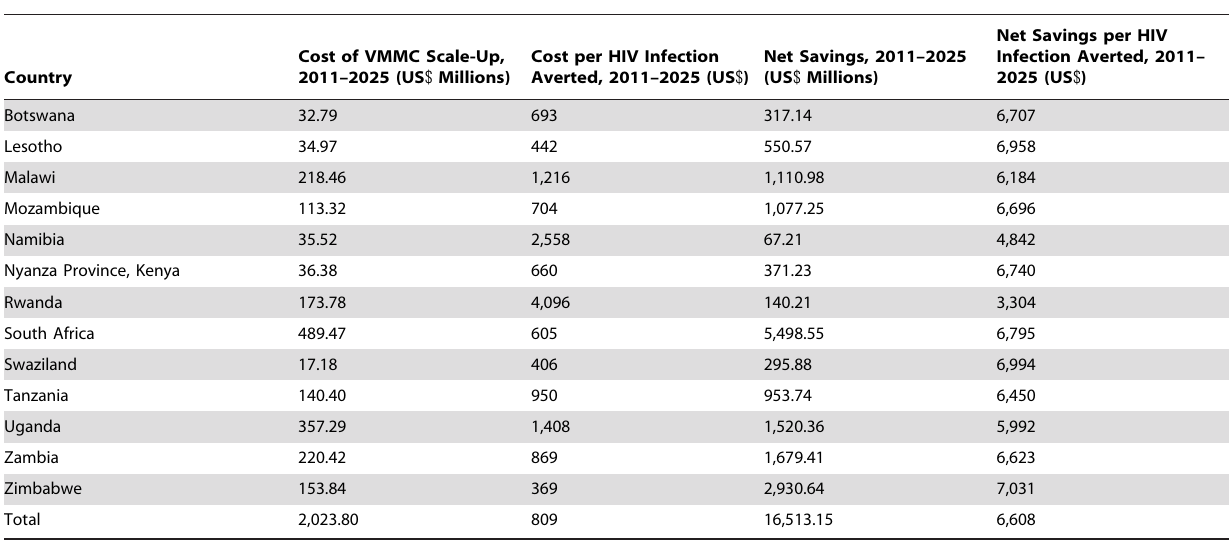
Table 5 provides the discounted cost of scaling up VMMC coverage, cost per HIV infection averted, and net savings per HIV infection averted for 2011–2025 for the base case scenario. HIV infections averted are discounted.